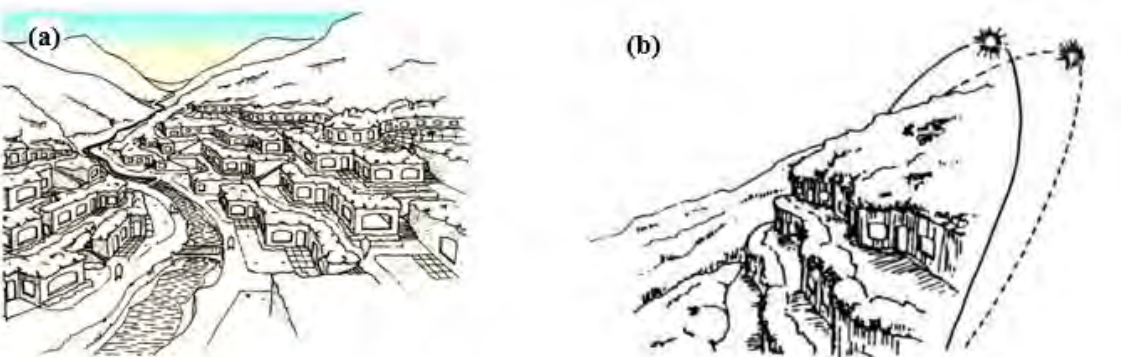
Figure 11. Recommendation of the cluster on the hill-side, using the compact(detached) form, towards the North (Golany and